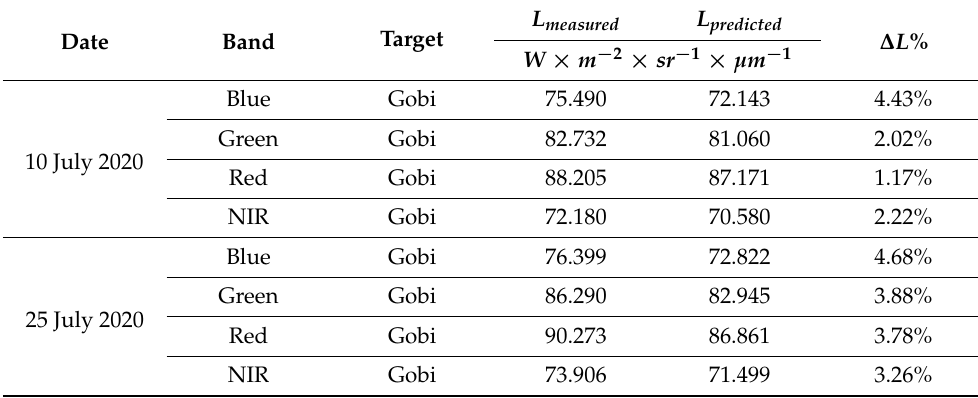
Figure 15. The GF-7 satellite Dunhuang test site acquisition geometry. Table 8. The absolute radiometric calibration result of the GF-7 satellite at the Baotou site.